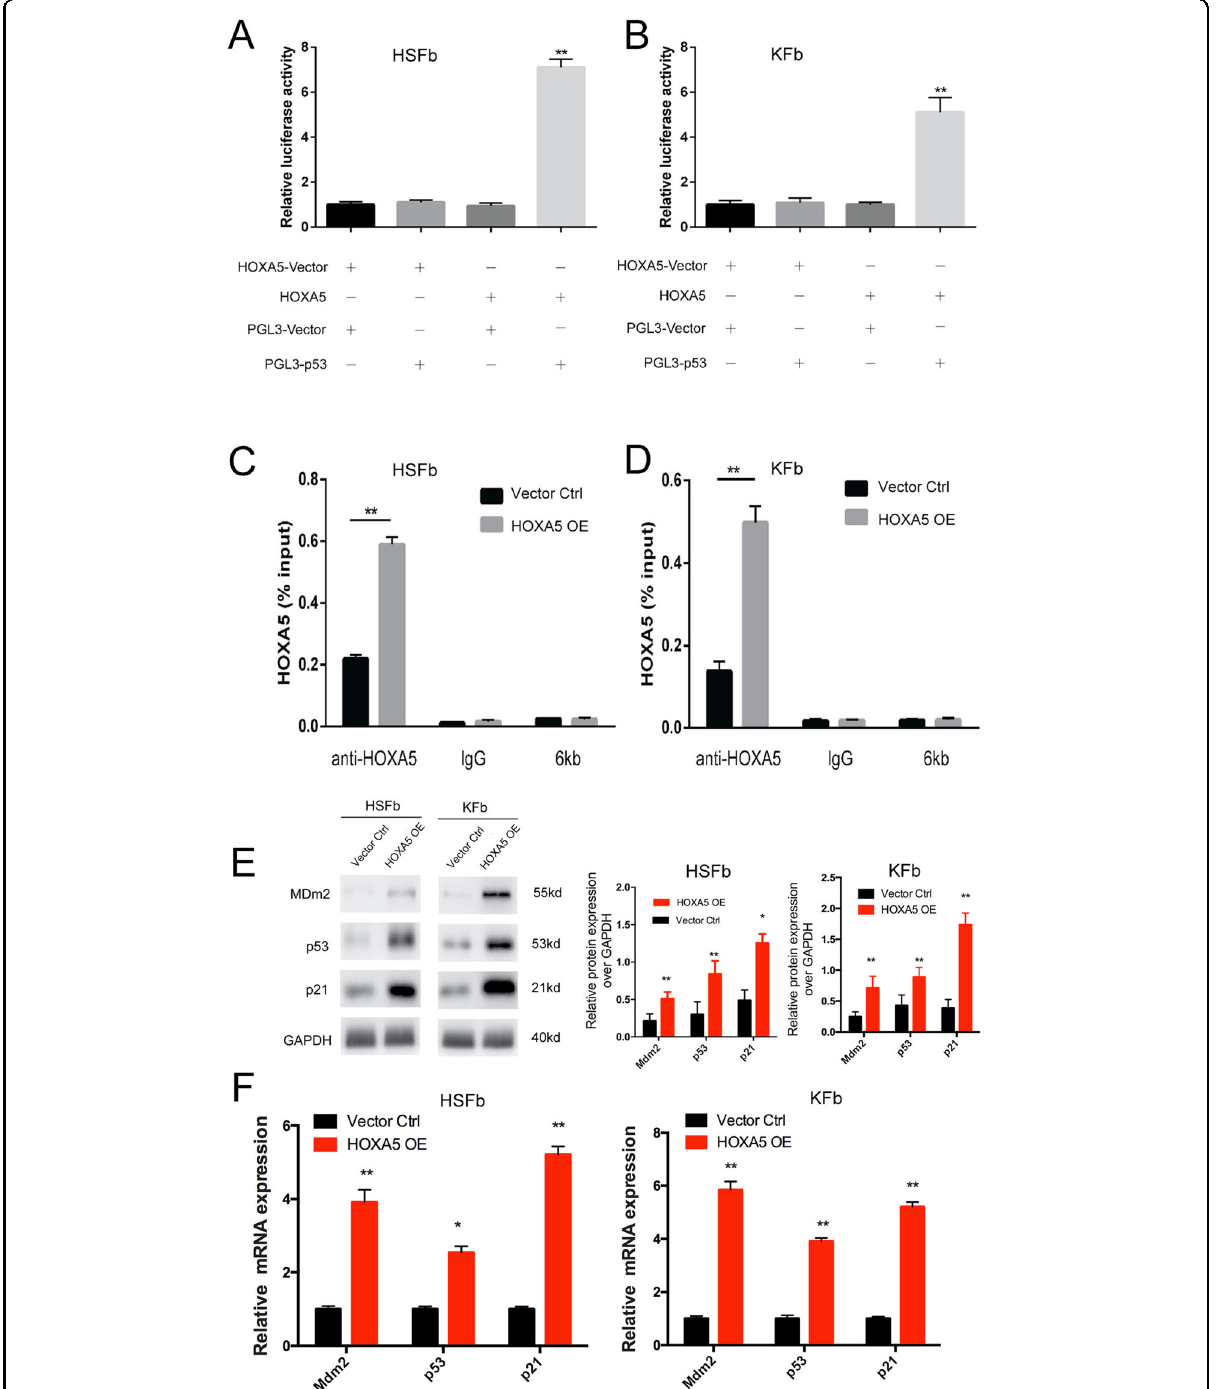
Fig. 3 HOXA5 binds to the p53 promoter and activates p53 signaling in both HSFb and KFb. A , B Luciferase assay data showed that HOXA5 activated the expression of p53 promoter reporter gene in KFb and HSFb. C , D ChIP data showed a direct interaction between HOXA5 and p53. 6 kb: the 6 kb upstream of the transcription start site, was used as a negative control for the transcription start site. E , F qPCR and western blot data showed that the overexpression of HOXA5 enhanced the expression of p21 and Mdm2, which are downstream targets of p53. * p < 0.05, ** p <